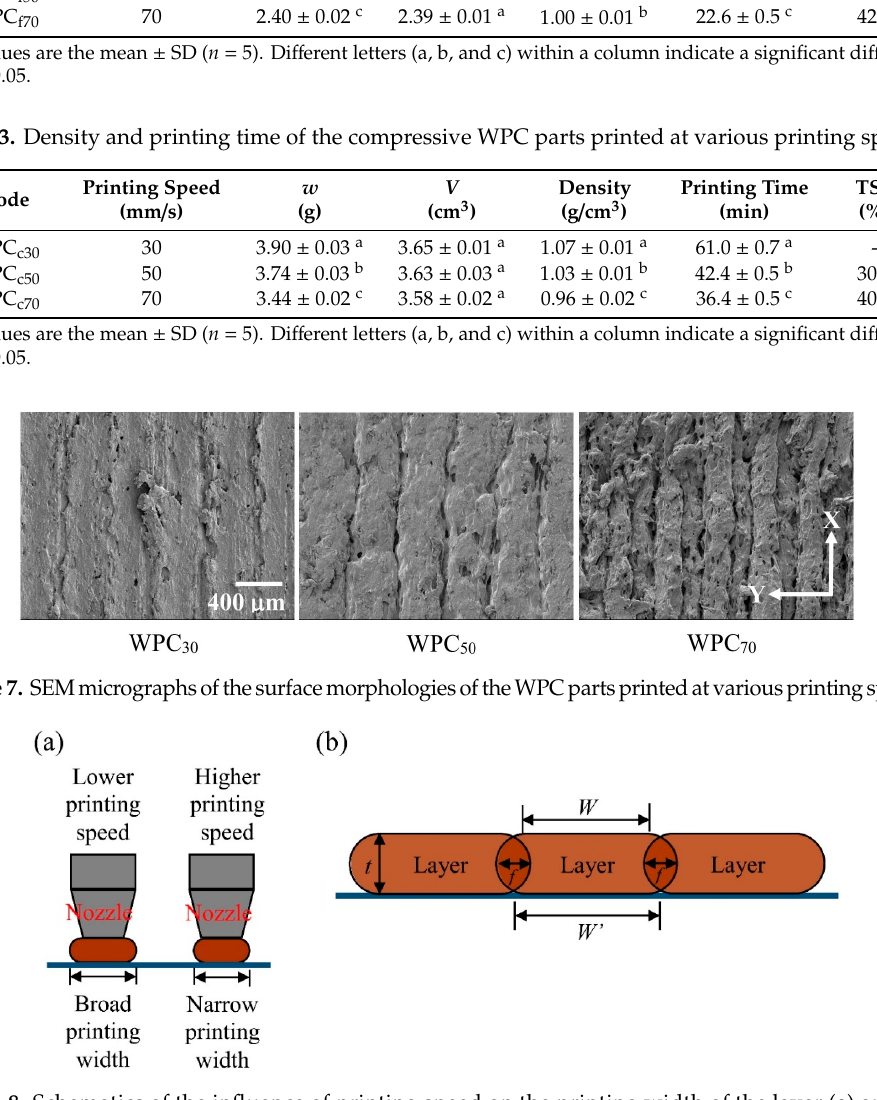
Figure 8. Schematics of the influence of printing speed on the printing width of the layer ( a ) and the adjacent layer with the overlapped offset ( b ).